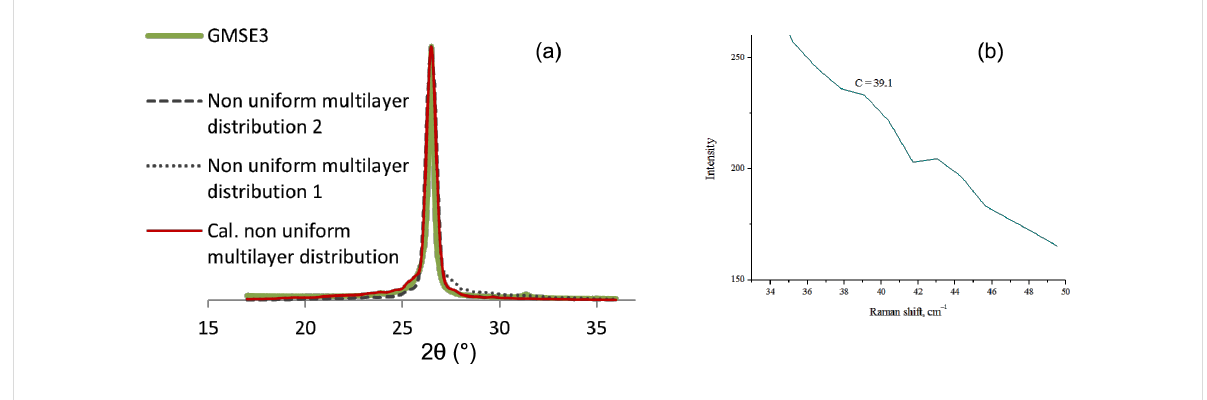
Figure 8: (a) Nonuniform multilayer distribution curve for sample GMSE3 calculated from Equaiton 3; (b) C -peak position in Raman spectrum for graphene sample GMSE3.